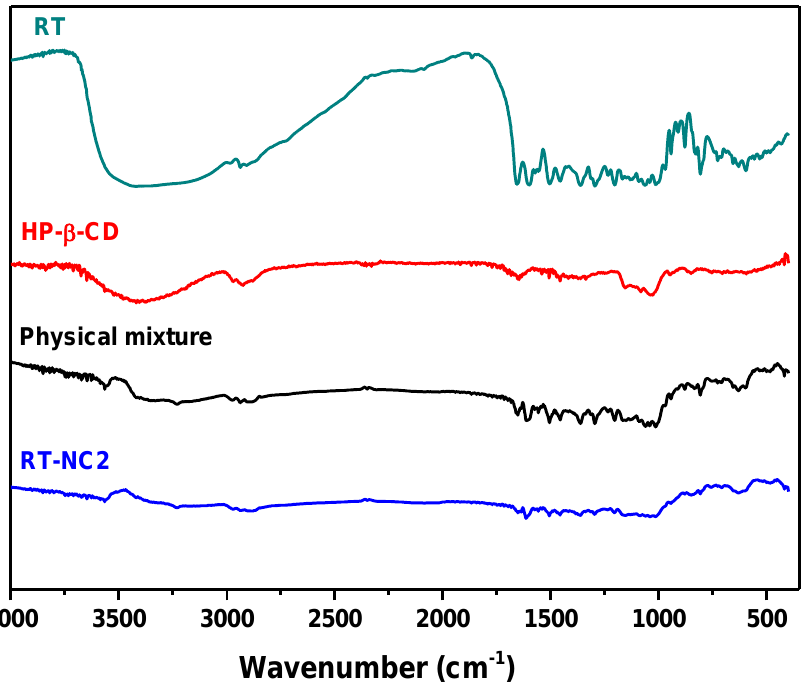
Figure 2. FT-IR spectra of rutin alone, HP- β -CD alone, their physical mixture (1:1, w / w ), and HP- β -CD-stabilized nanocrystals (formulation RT-NC2).